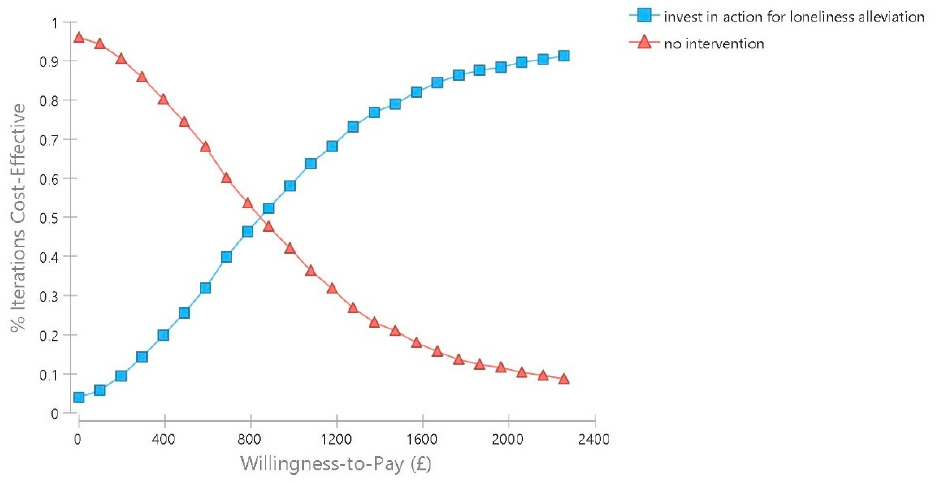
Figure 4. Probabilistic sensitivity analysis, loneliness alleviation versus no action.